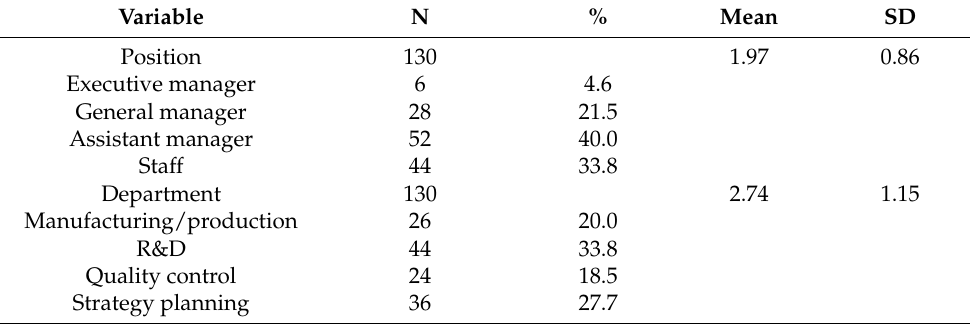
Table 1. Demographic characteristics for respondents ( n = 130).